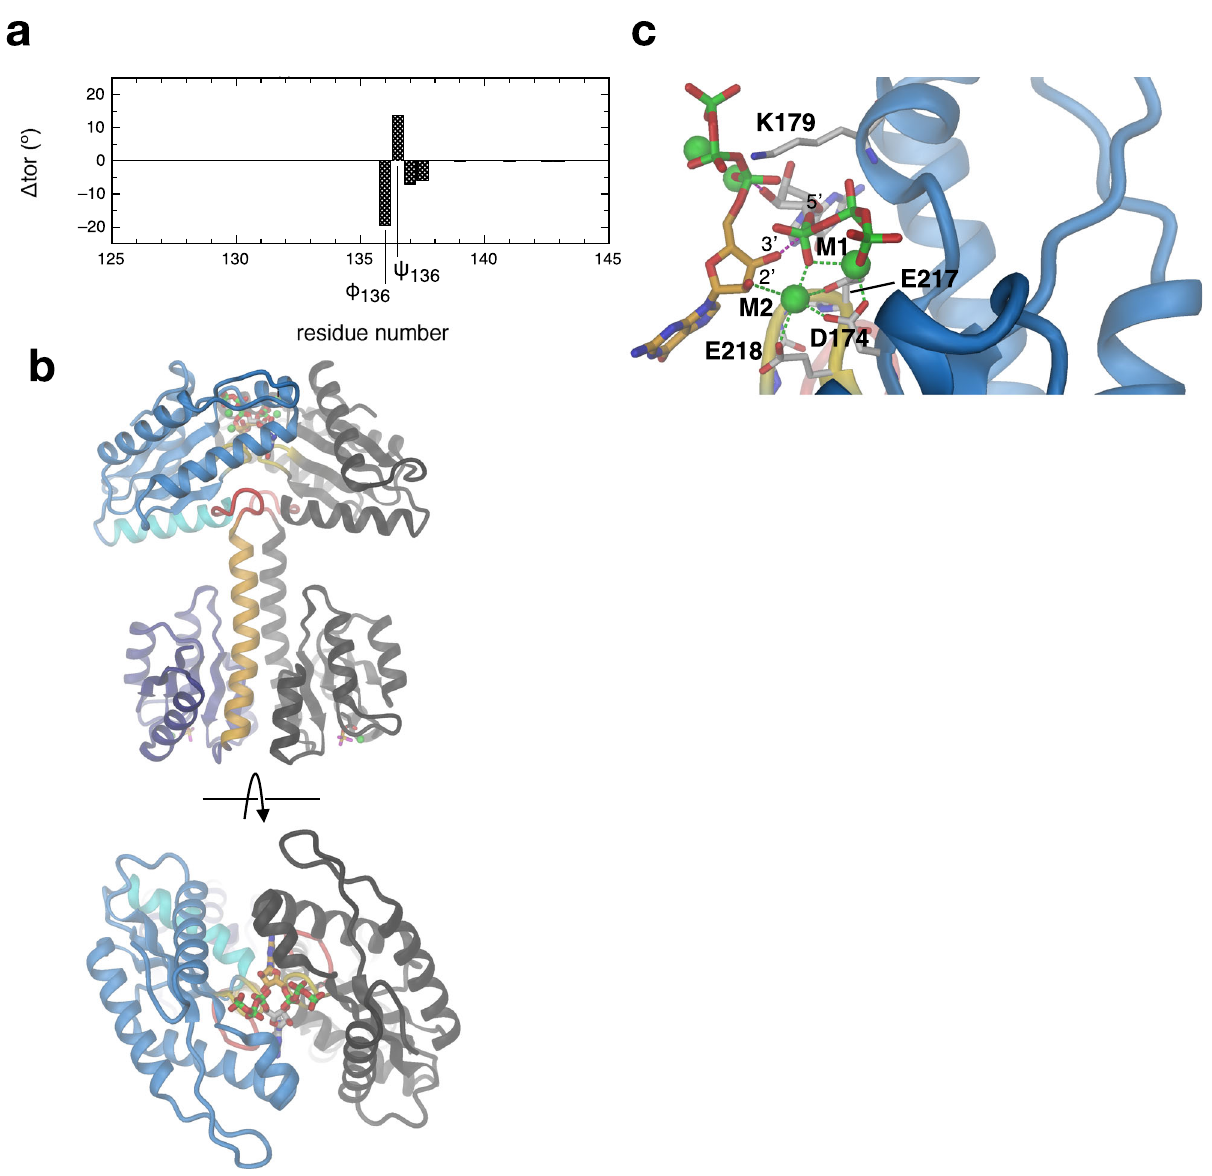
Fig. 6 The activated Rec dimer allows formation of a catalytically competent GGDEF dimer. a Changes in main-chain dihedral angles ( Δ tor) applied manually to DgcR ’ * to move the two GGDEF domains into catalytically competent arrangement. b Model of competent DgcR (two orthogonal views) generated as described in a . c Detailed view of the competent juxtaposition of the two GGDEF bound GTP substrate molecules. The carbon atoms of the two GTP molecules are coloured in orange and grey, respectively. The O3 ’ hydroxyl of each ligand is poised for nucleophilic attack on the α -phosphorous (PA) of the other ligand being roughly inline with the scissile PA – O3A (Fig. 7e) and, fi nally, assemble to form (5) the catalytically competent constellation Michaelis – Menten complex (Fig. 7f). An